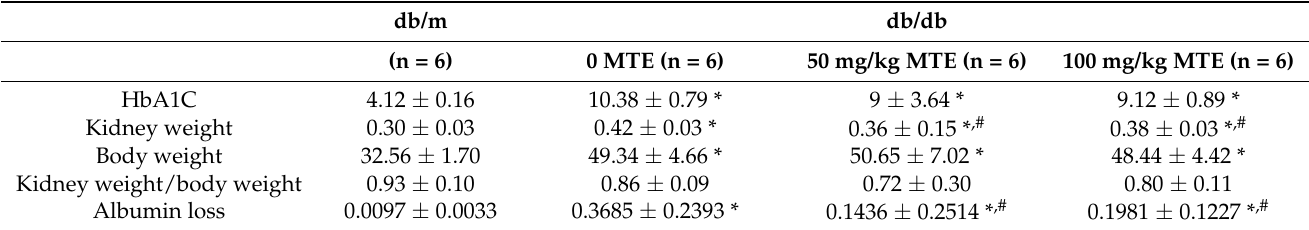
Table 1. Effect of PPG on HbA1C, body weight, kidney weight, albumin loss, and total protein loss in diabetic rats. db/m db/db